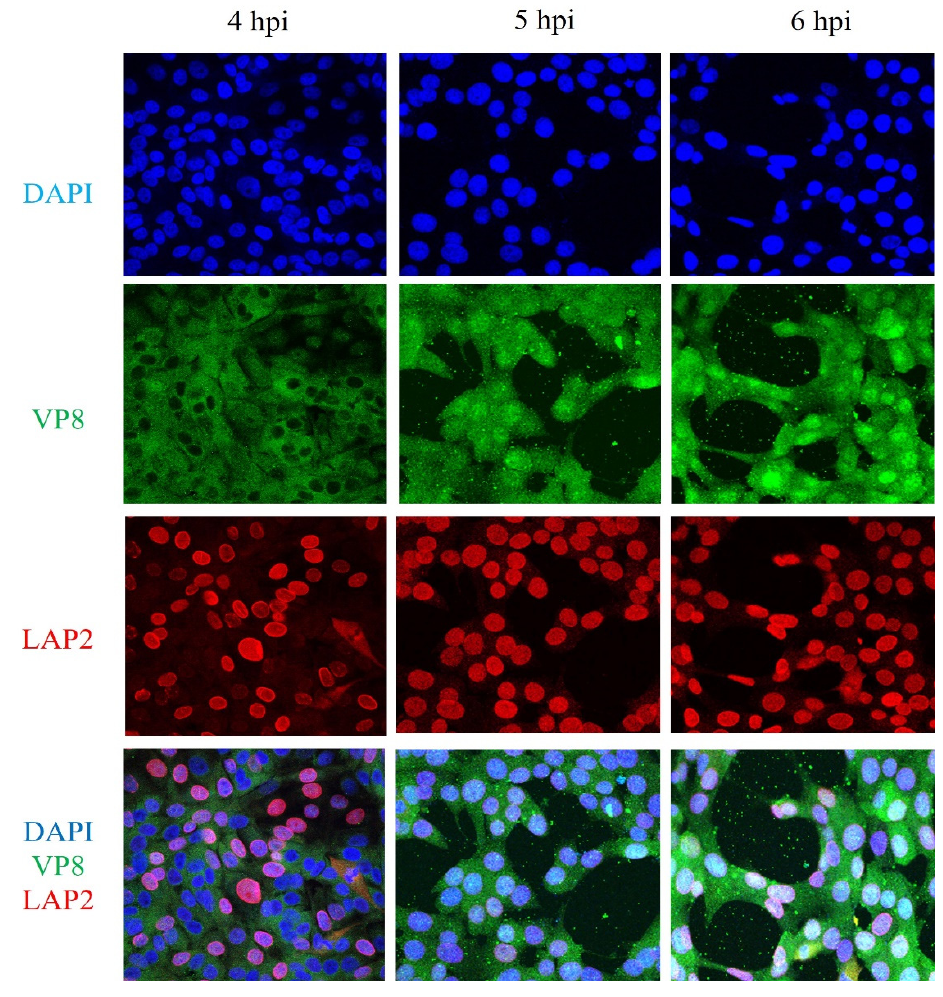
Figure 11. VP8 does not localise in the perinuclear region in BoHV-1 Δ UL49- infected cells. MDBK cells were infected with BoHV-1 Δ UL49 at an MOI of 5, and fixed and permeabilized 4, 5, or 6 h post infection. VP8 was identified with rabbit VP8-specific antibody and Alexa 488-conjugated goat anti- rabbit IgG. LAP2 was detected with monoclonal LAP2-specific antibody and Alexa 633-conjugated anti-mouse IgG. No yellow and, hence, no presence of VP8 in the perinuclear region, was detected.